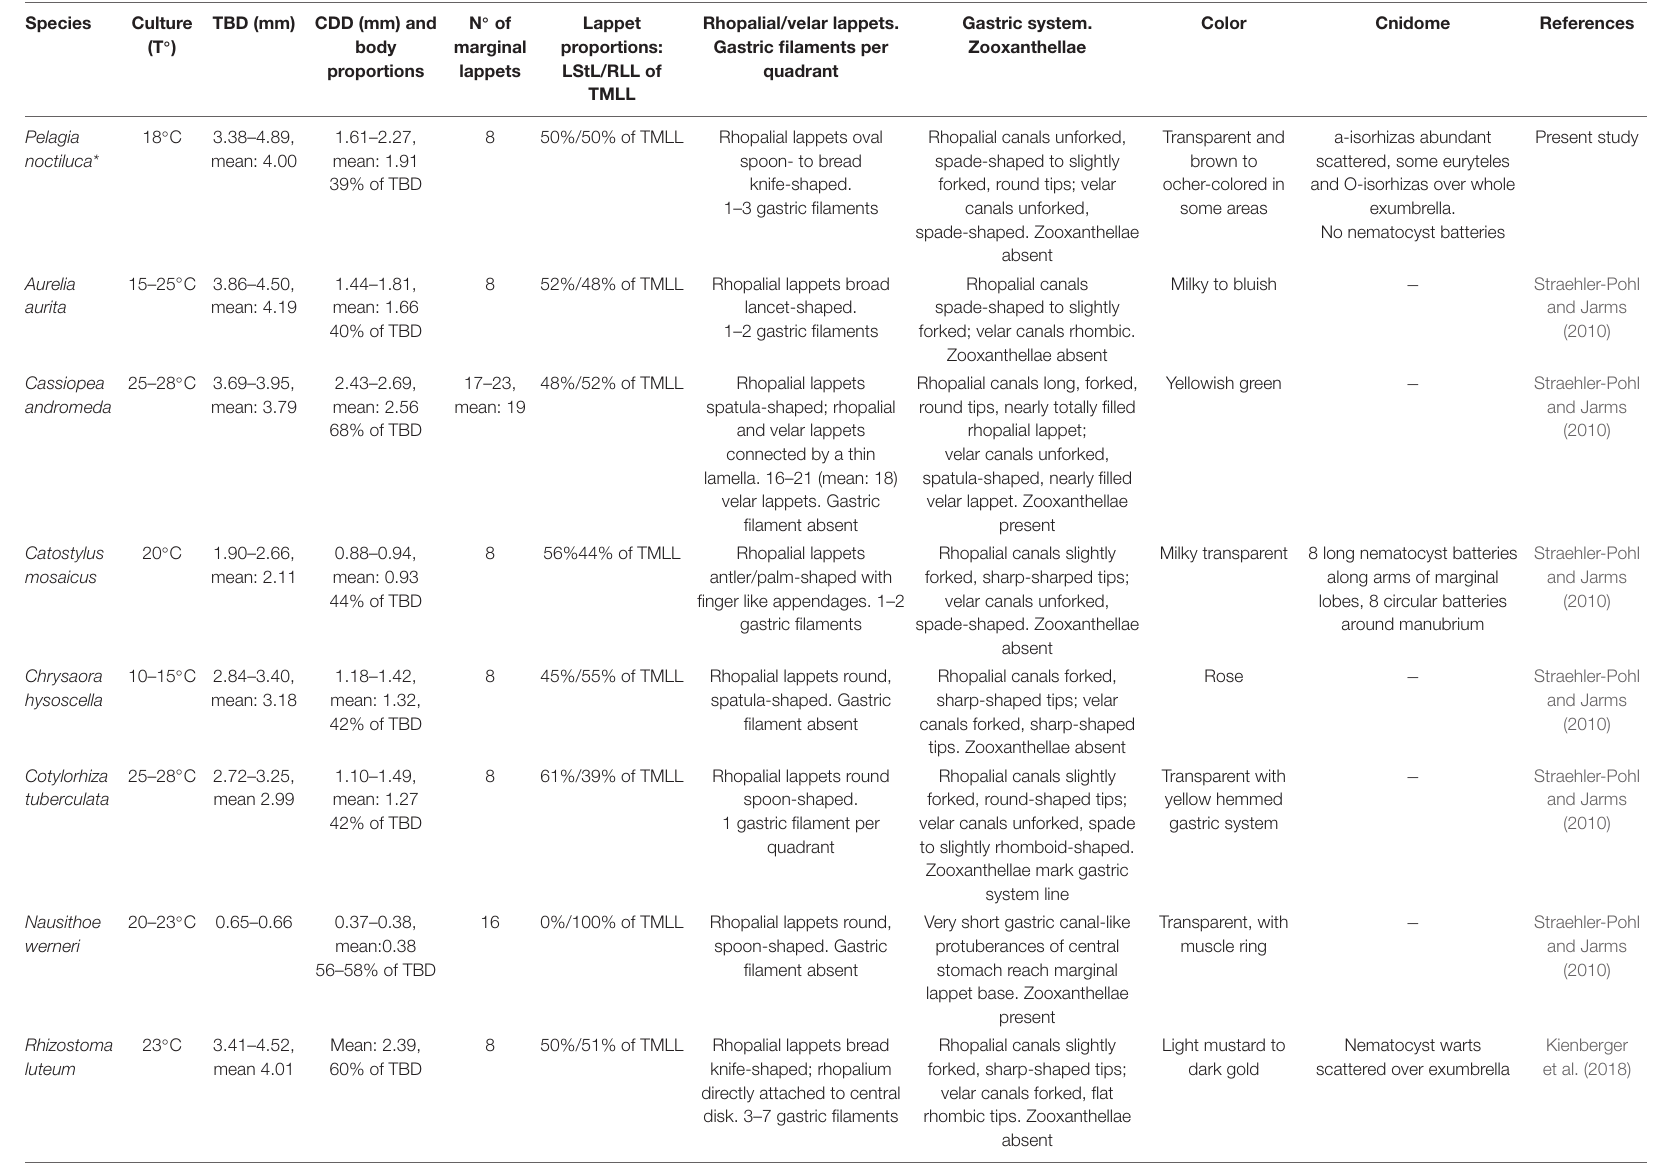
TABLE 3 | Morphology including cnidome of scyphozoan ephyrae present in the Mediterranean Sea.